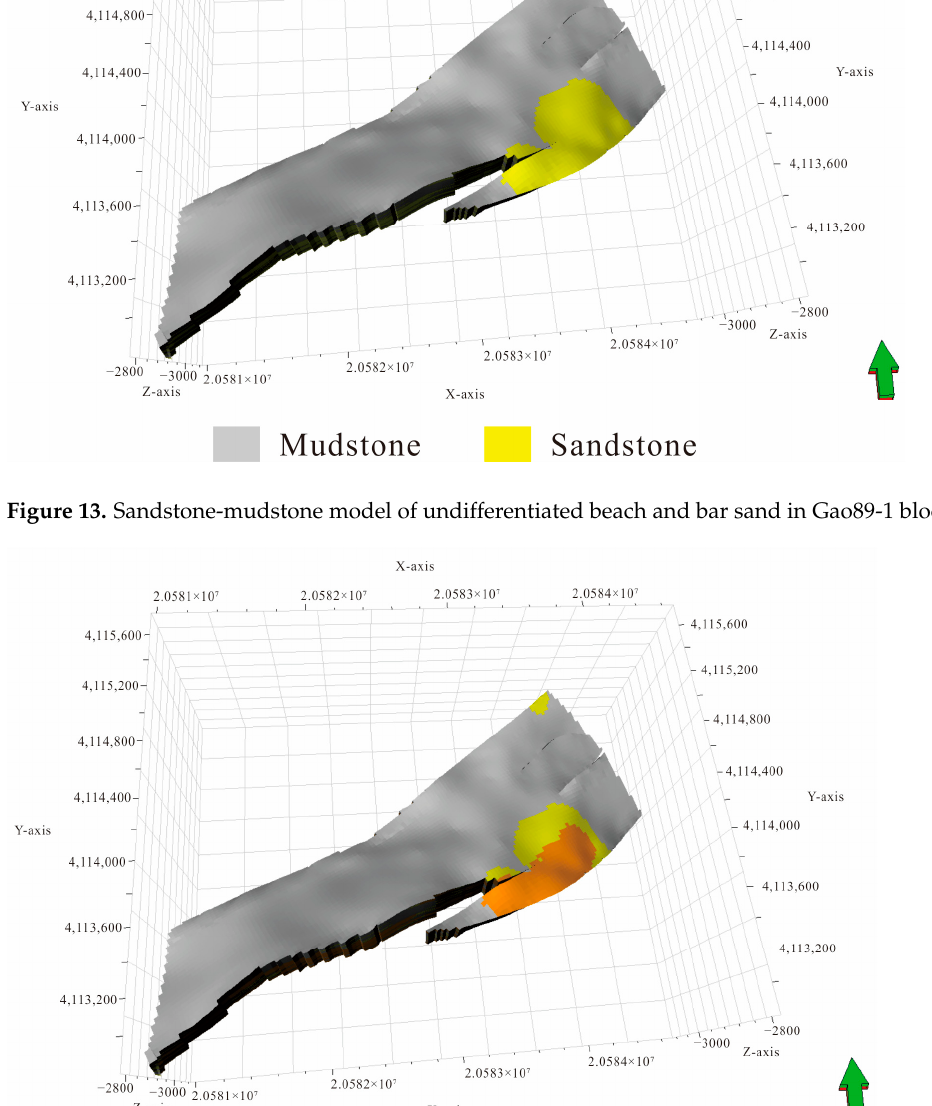
Figure 14. Beach-bar model that distinguished between beach and bar sand in Gao89-1 block.